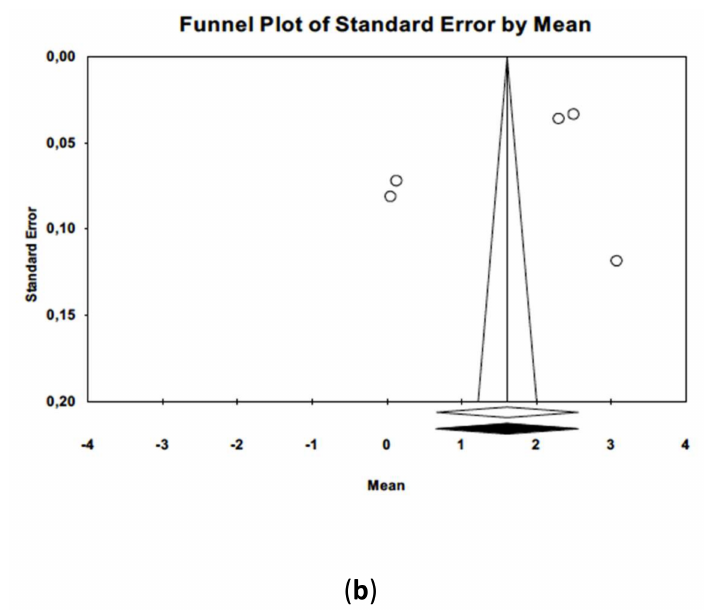
Figure 9. ( a ) Forest plot of probing attachment level meta-analysis. ( b ) Funnel plot with observed and imputed studies.